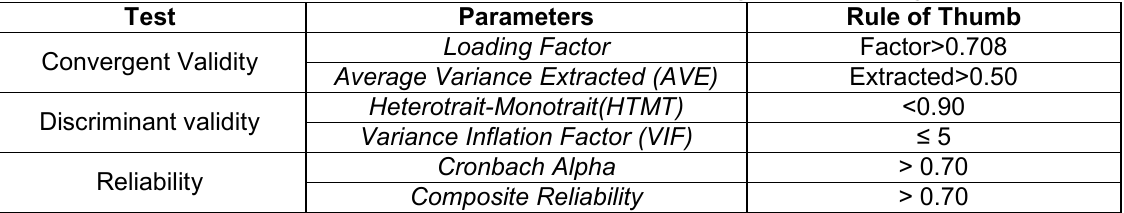
Table 2: Parameter Measurement Model Validity and